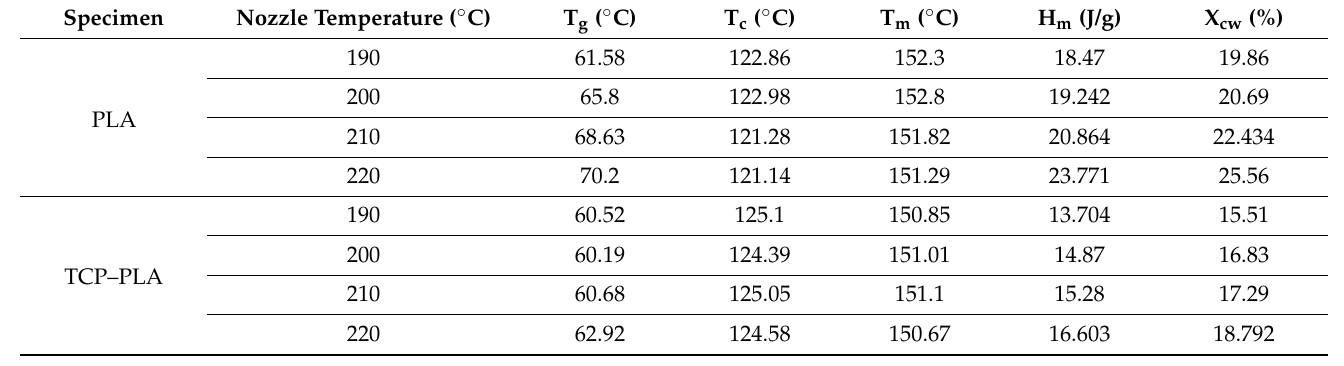
Table 2. Thermal properties of PLA and TCP–PLA samples printed at different nozzle temperatures.